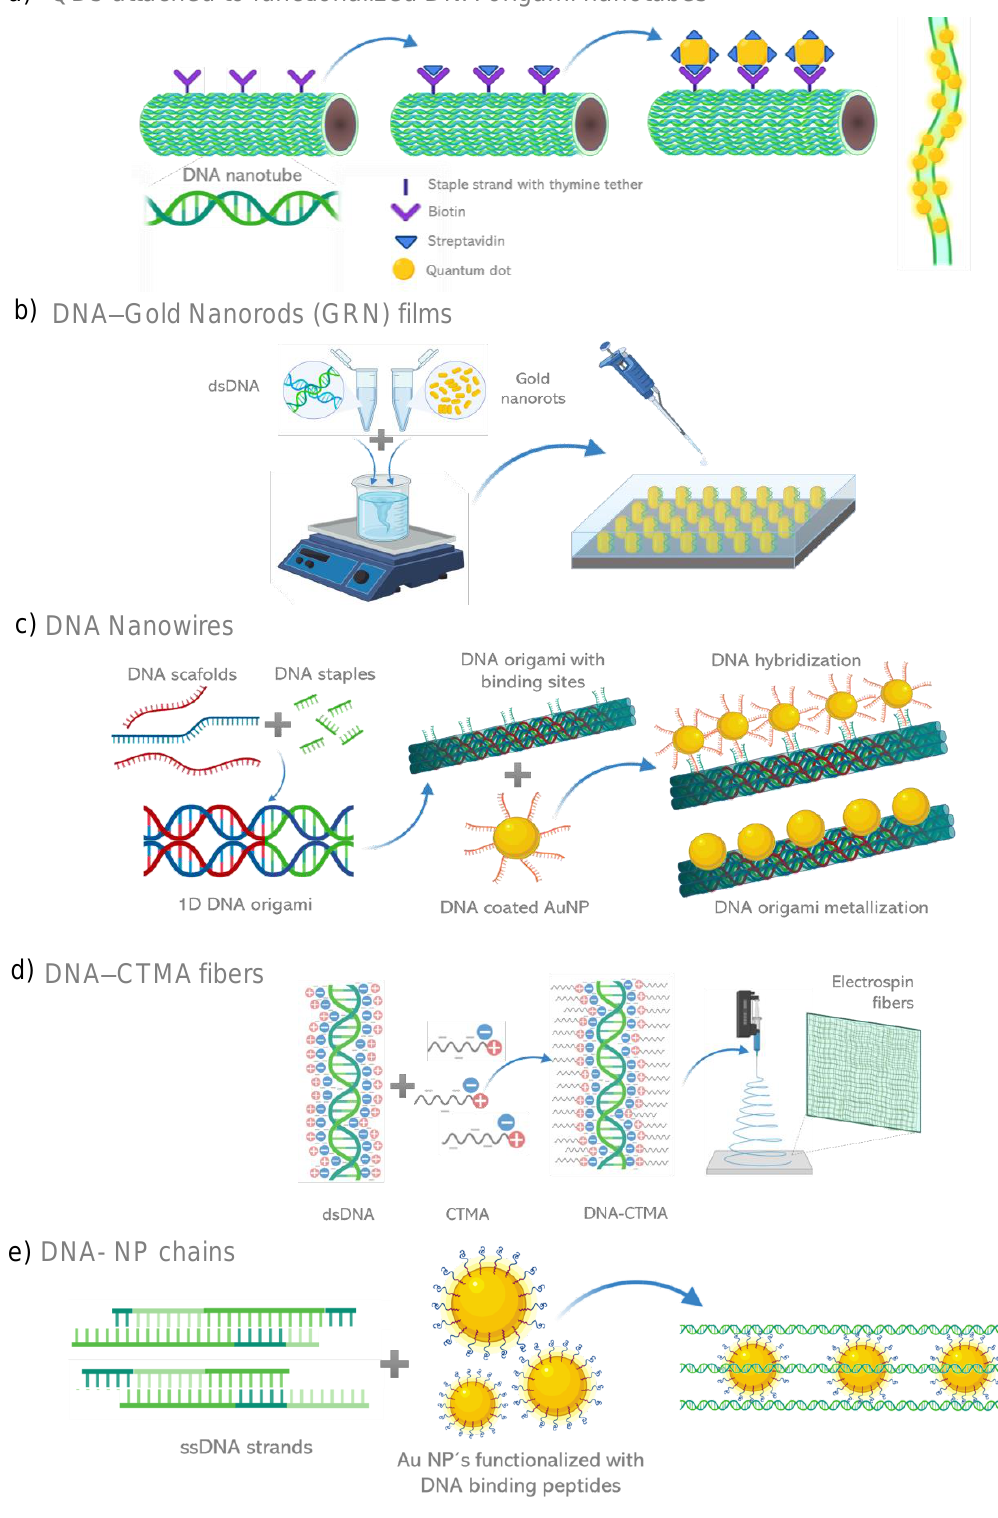
Figure 5. One dimensional (1D) DNA nanostructures. ( a ) Quantum dots attached to functionalized DNA origami nanotubes, ( b ) DNA gold nanorods films, ( c ) construction of DNA nanowires through the assembly of DNA origami and DNA coated AuNPs, ( d ) Electrospin fibers made of DNA-CTMA, ( e ) Formation of NP chains with the interaction between ssDNA strands and AuNPs functionalized with DNA binding